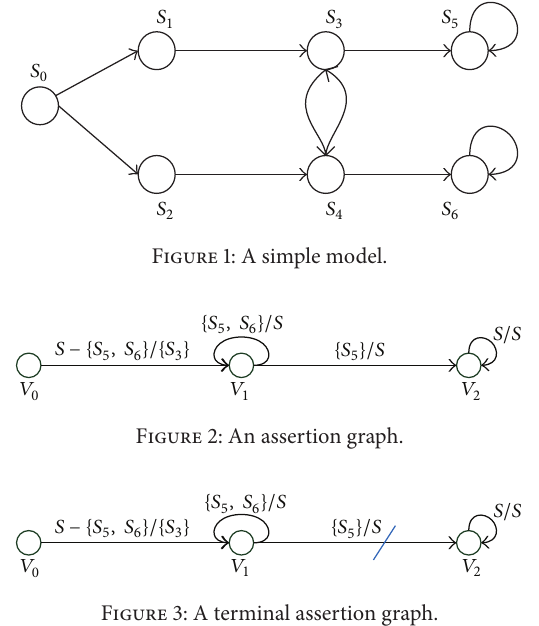
Figure 3: A terminal assertion